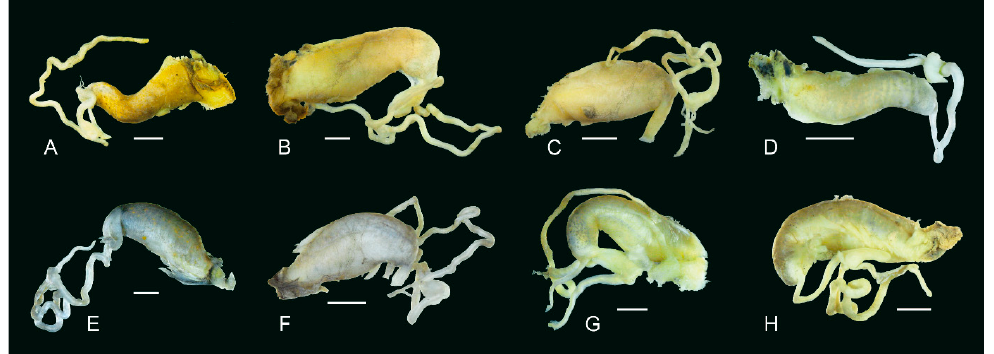
Figure 9. Variability in male genitalia of Radix auricularia from Lake Baikal: ( A ) Listvenichnoe, 1–9 m depth ( Radix Baikal 13); ( B ) Listvenichnoe, 1–9 m depth ( Radix Baikal 12); ( C ) Maloye More, Shibeteyskaya Bay, in a depth of 24–25 m ( Radix Baikal 11); ( D ) North of Cape Elokhin, 4–10 m depth ( Radix Baikal 3); ( E ) North of Buguldeyka, 2–3 m depth ( Radix Baikal 1); ( F ) North of Buguldeyka, 2–3 m depth ( Radix Baikal 2); ( G ) North of Cape Elokhin, 4–10 m depth ( Radix Baikal 4); ( H ) Senogda Bay, 1.5 m depth ( Radix Baikal 8). Scale bars = 1 mm.